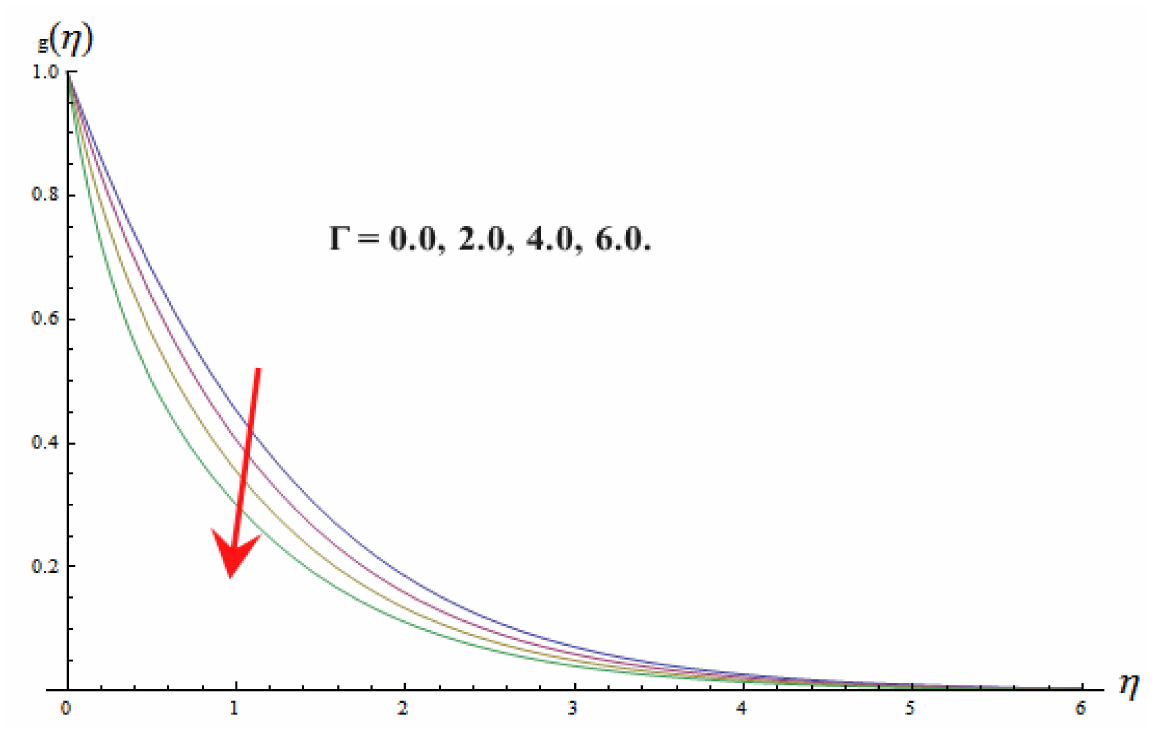
Figure 7. Impact of Γ on g ( η ) keeping λ 1 = 2, Pr = 2, Br = 2, λ = 2, Ec = 0.2, Rd = 2, β 1 = 0.2, Ha = 2, K ∗ =